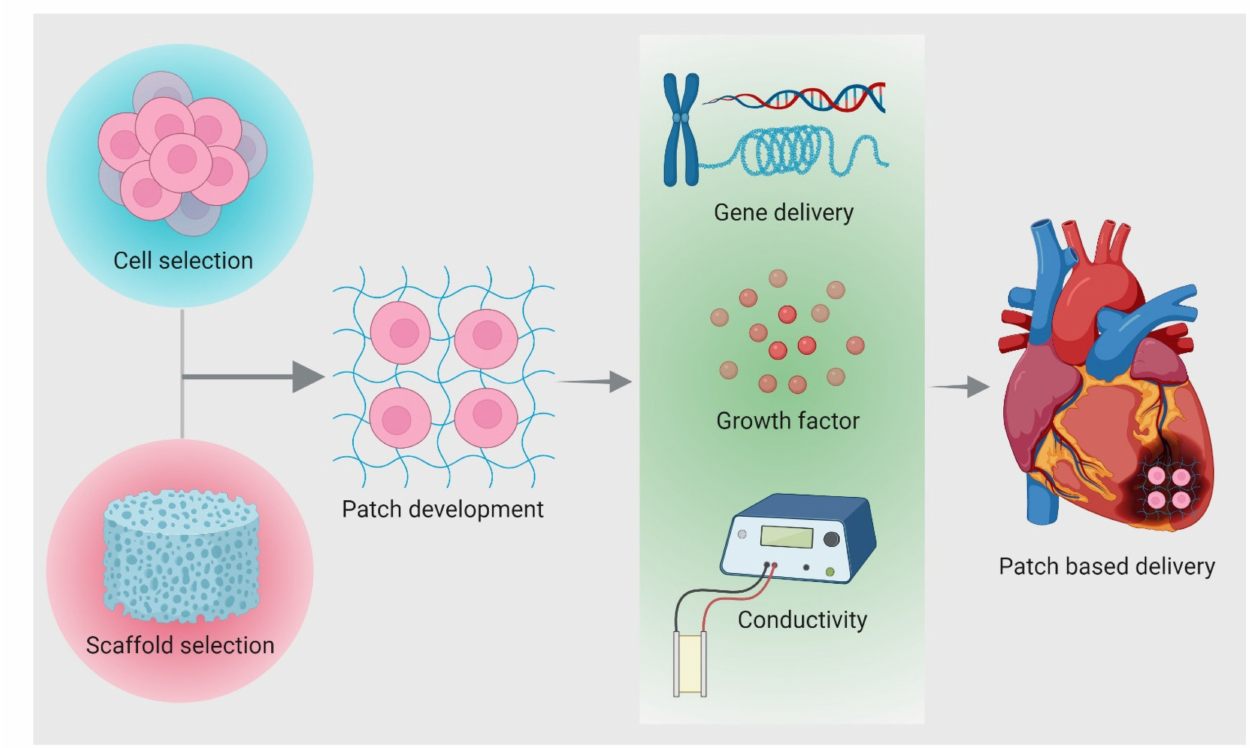
Figure 4. Patch-based cell therapy development started with the fabrication of different patches made up of carbon nanostructures, conductive or non-conductive polymers, hydrogel, etc. followed by patch-based stem cell delivery for MI disease